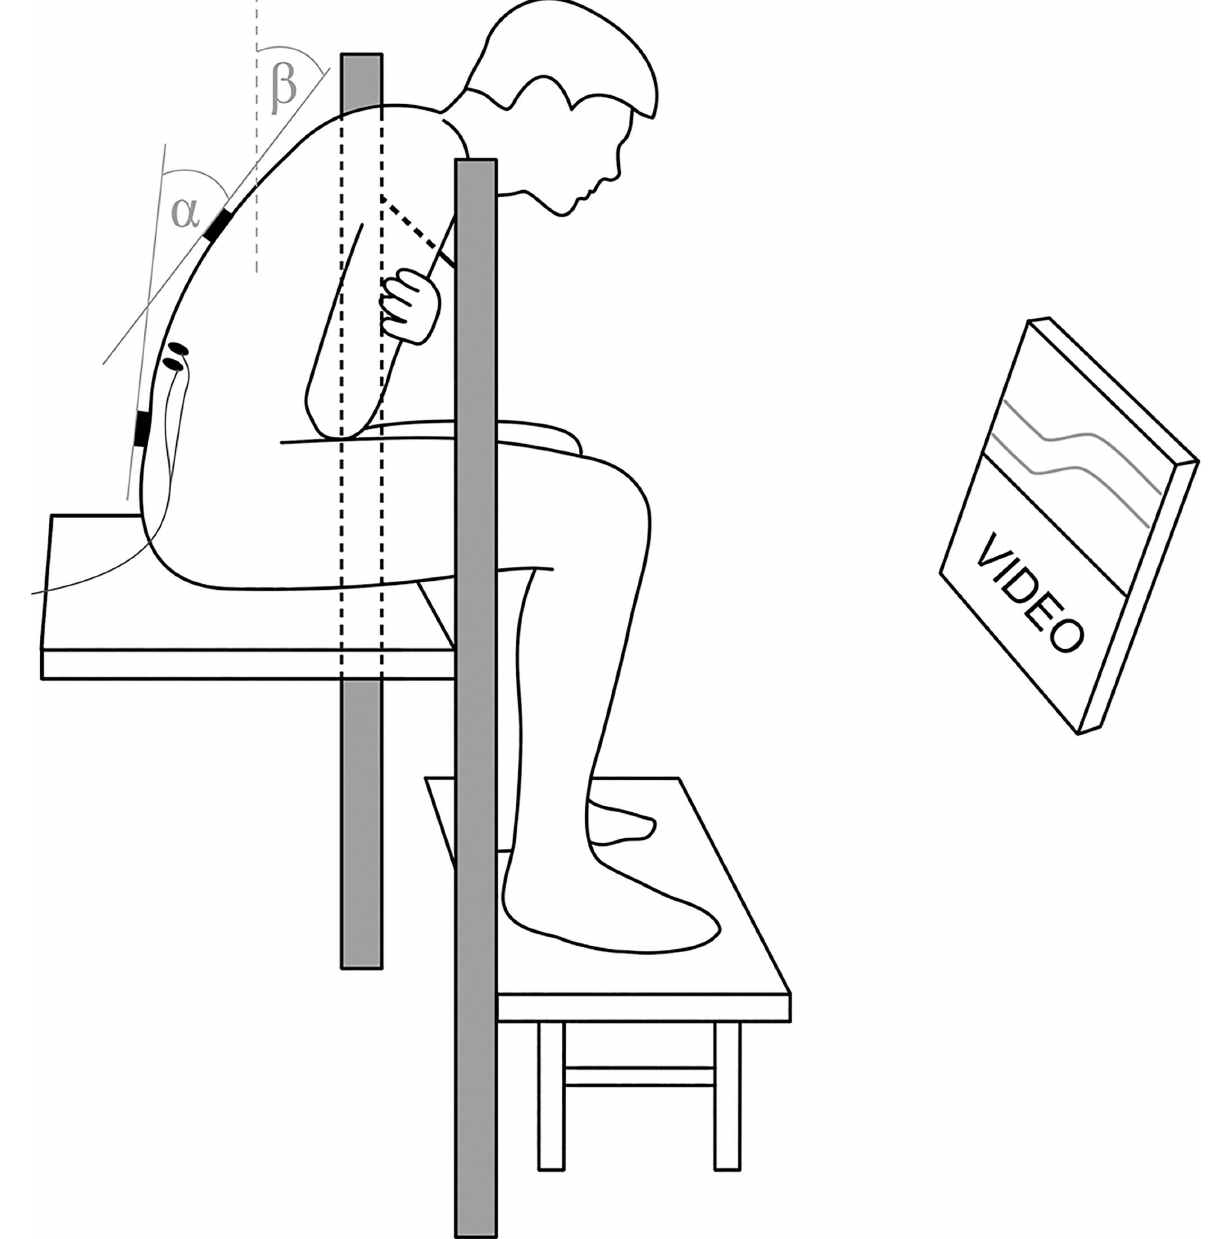
Fig 2. Position of the participant during intermittent flexion. Visual feedback was provided to the participant about the lumbar flexion ( α ) and trunk inclination( β ) with marks for the requiredposition. In the unsupported condition, a thin rope was placed horizontally in front of the participantat the appropriate height to serve as the orientationpoint during the flexion and in the supported position the rope was replacedby a paddedbar on which the participantwas leaningduring the